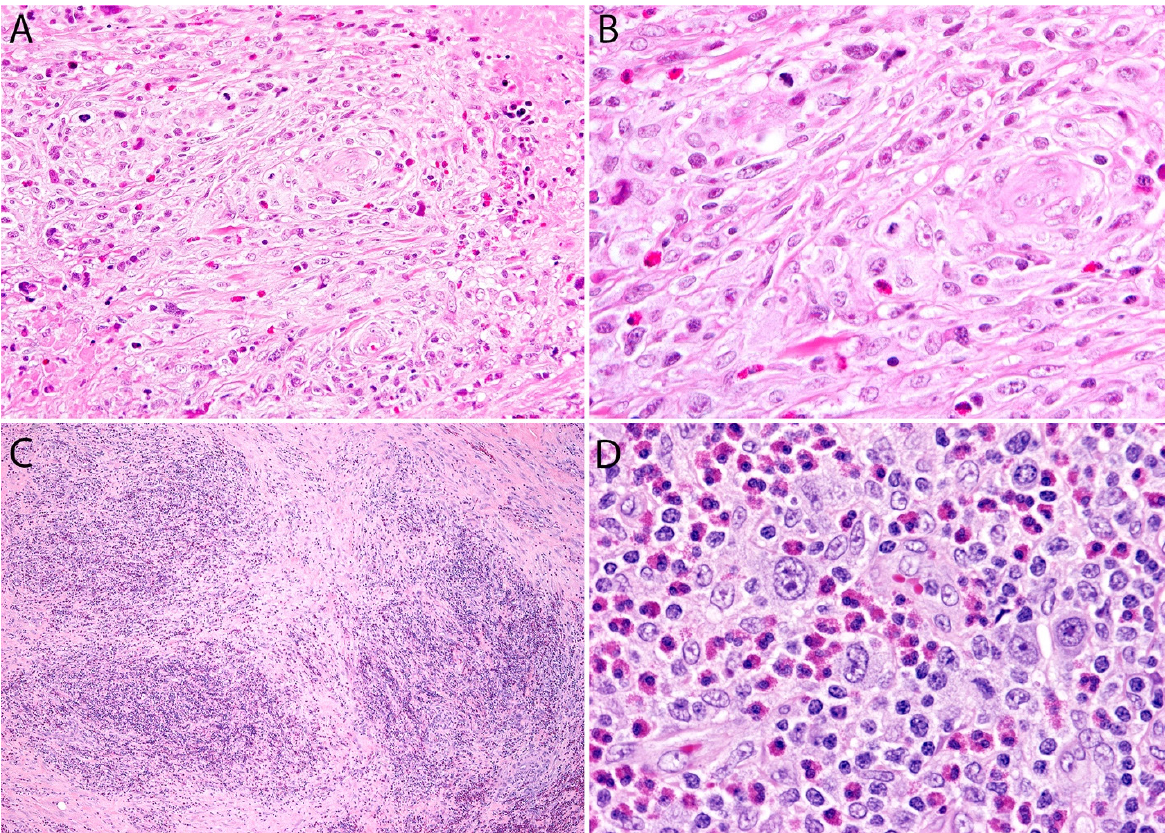
Figure 3. Variants of systemic ALK- ALCL. ( A , B ) Sarcomatoid ALCL. Note the perivascular arrangement and the focal areas of necrosis at the periphery. Occasional “hallmark” cells are seen. ( C , D ) “Hodgkin-like” ALCL. This variant is identical to nodular sclerosis classic Hodgkin lymphoma and can only be distinguished by immunohistochemistry. The tumor cells in both cases were positive for CD30, CD4, and other T-cell markers, and were negative for CD8, CD15, PAX5, and ALK (not shown in Figure).